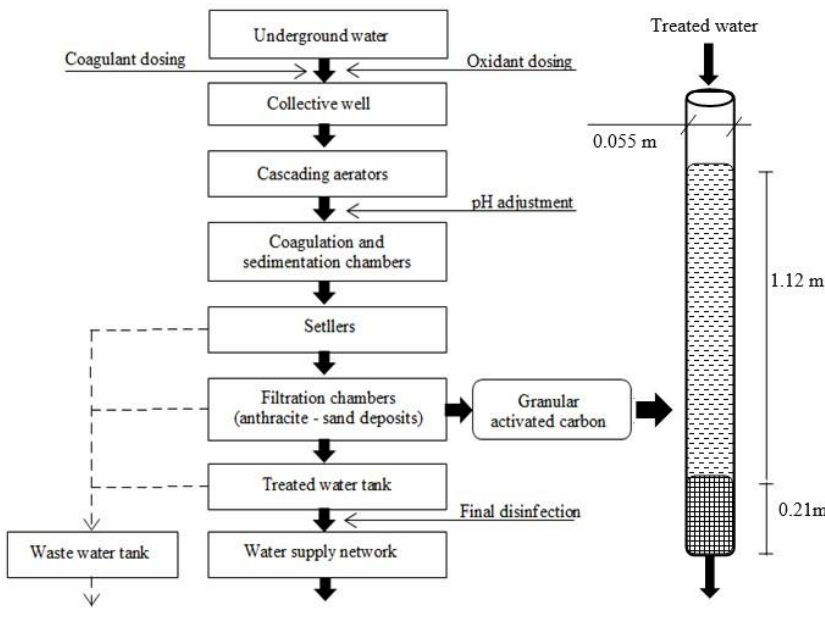
Figure 1. Technological flowchart for the Water Treatment Plant. Table 2. Parameters of the biofilter model [18].